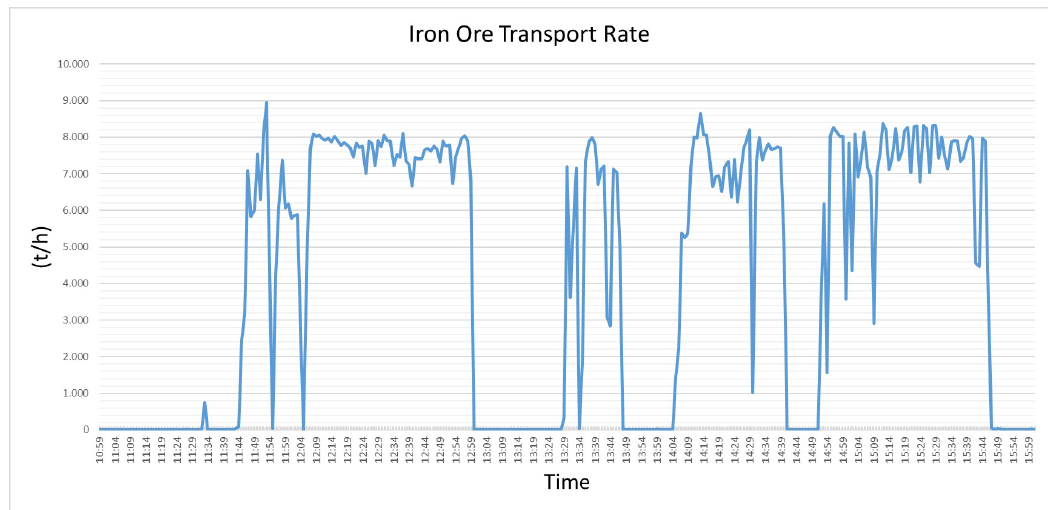
Figure 7. This chart shows how transport rate of one conveyor belt line can drop instantaneously and then recover the previous value of rate.